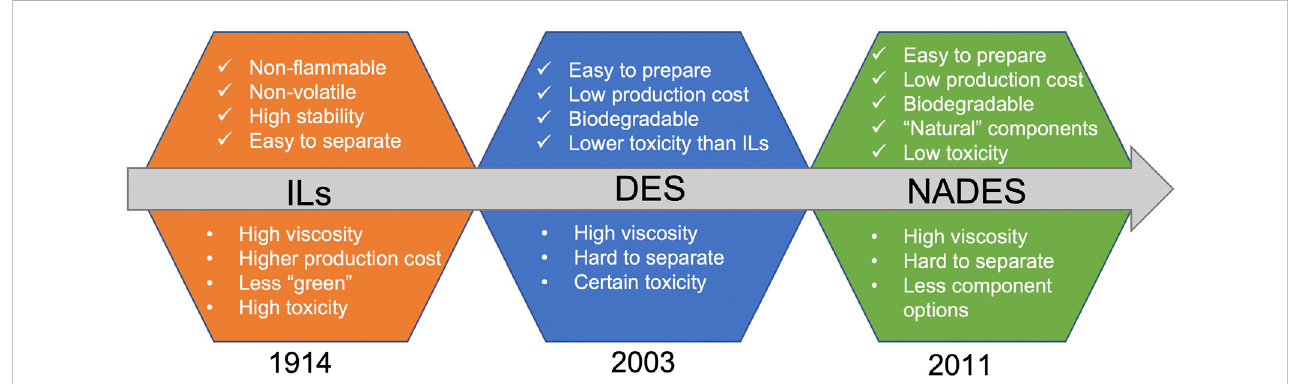
FIGURE 1 Timeline of reported developments and properties of ILs, DES, and NADES. DES, deep eutectic solvents; ILs, ironic liquids; NADES, natural deep eutectic